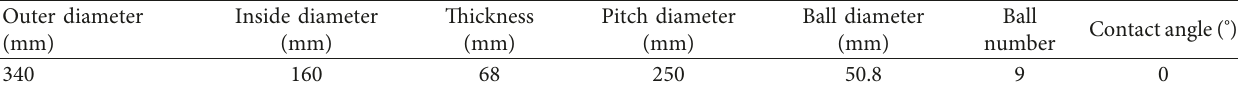
Table 5: Structural parameters of the bearing.